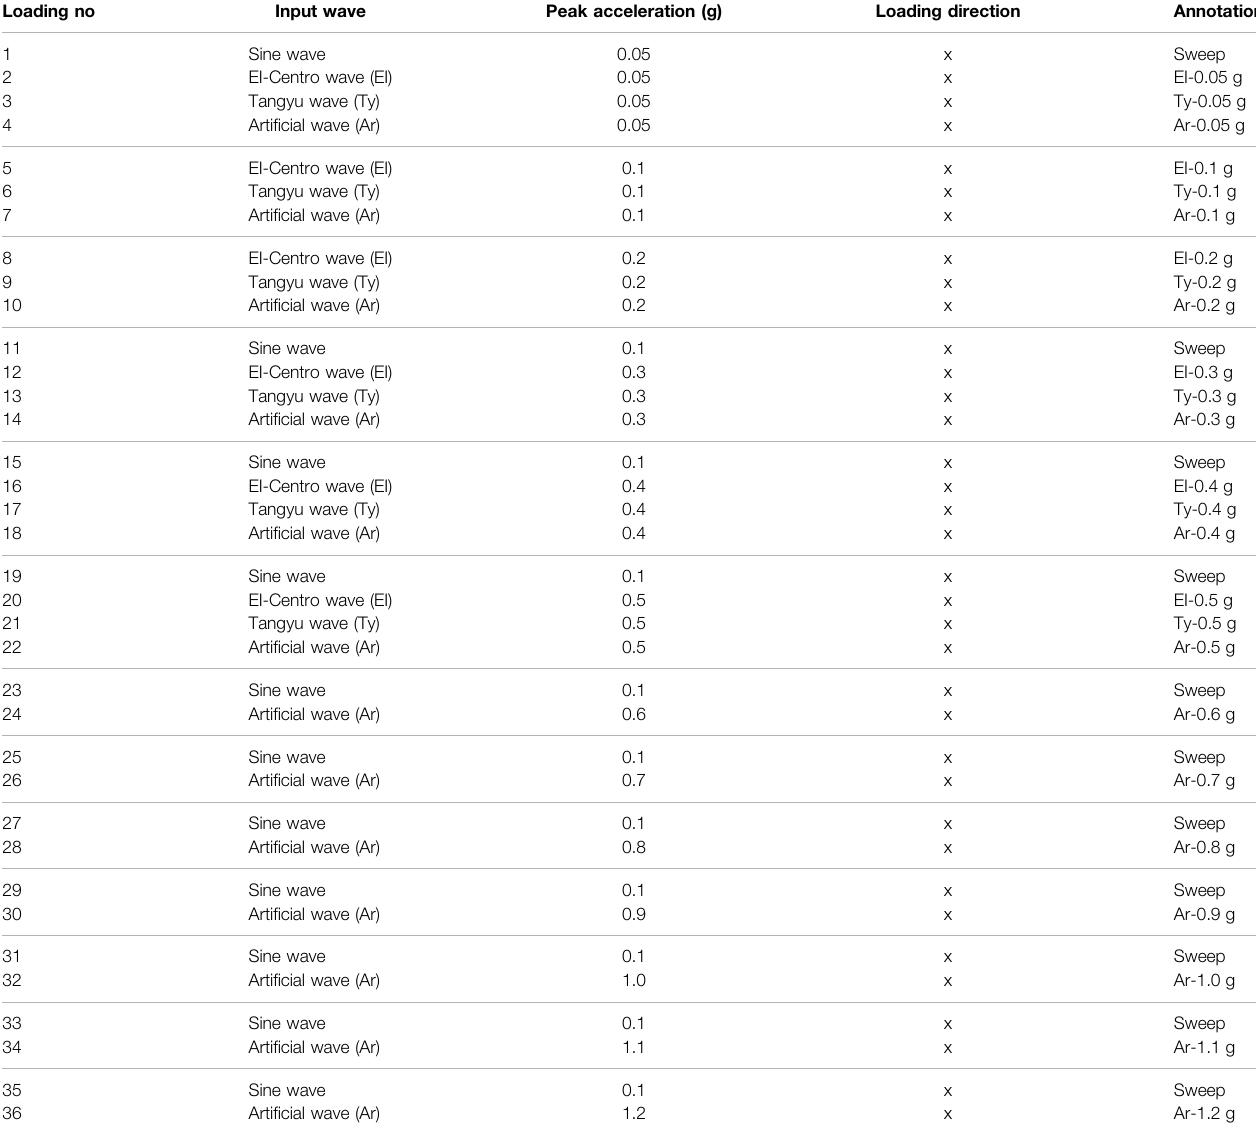
TABLE 3 | Loading scheme of the vibration table experiment. Loading